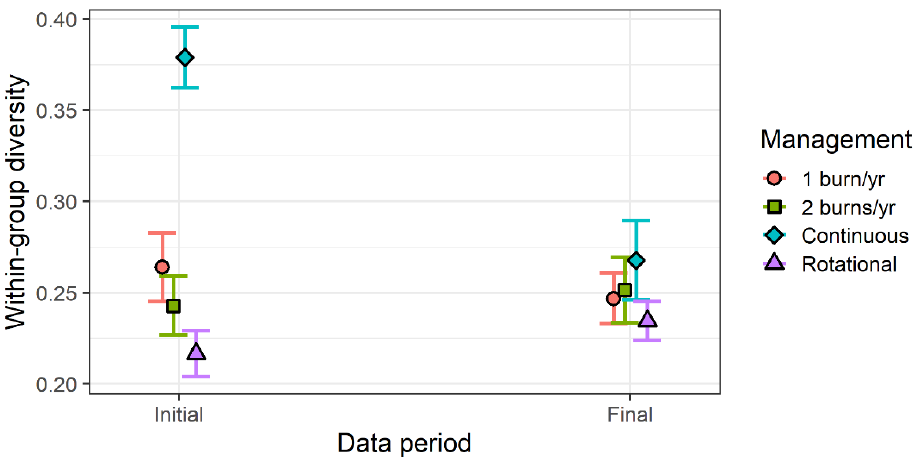
Figure 5. Changes in beta diversity (group area in ordination space) over time under four grazing regimes at the Central Grasslands Research Extension Center in Streeter, ND. Error bars represent one standard error.